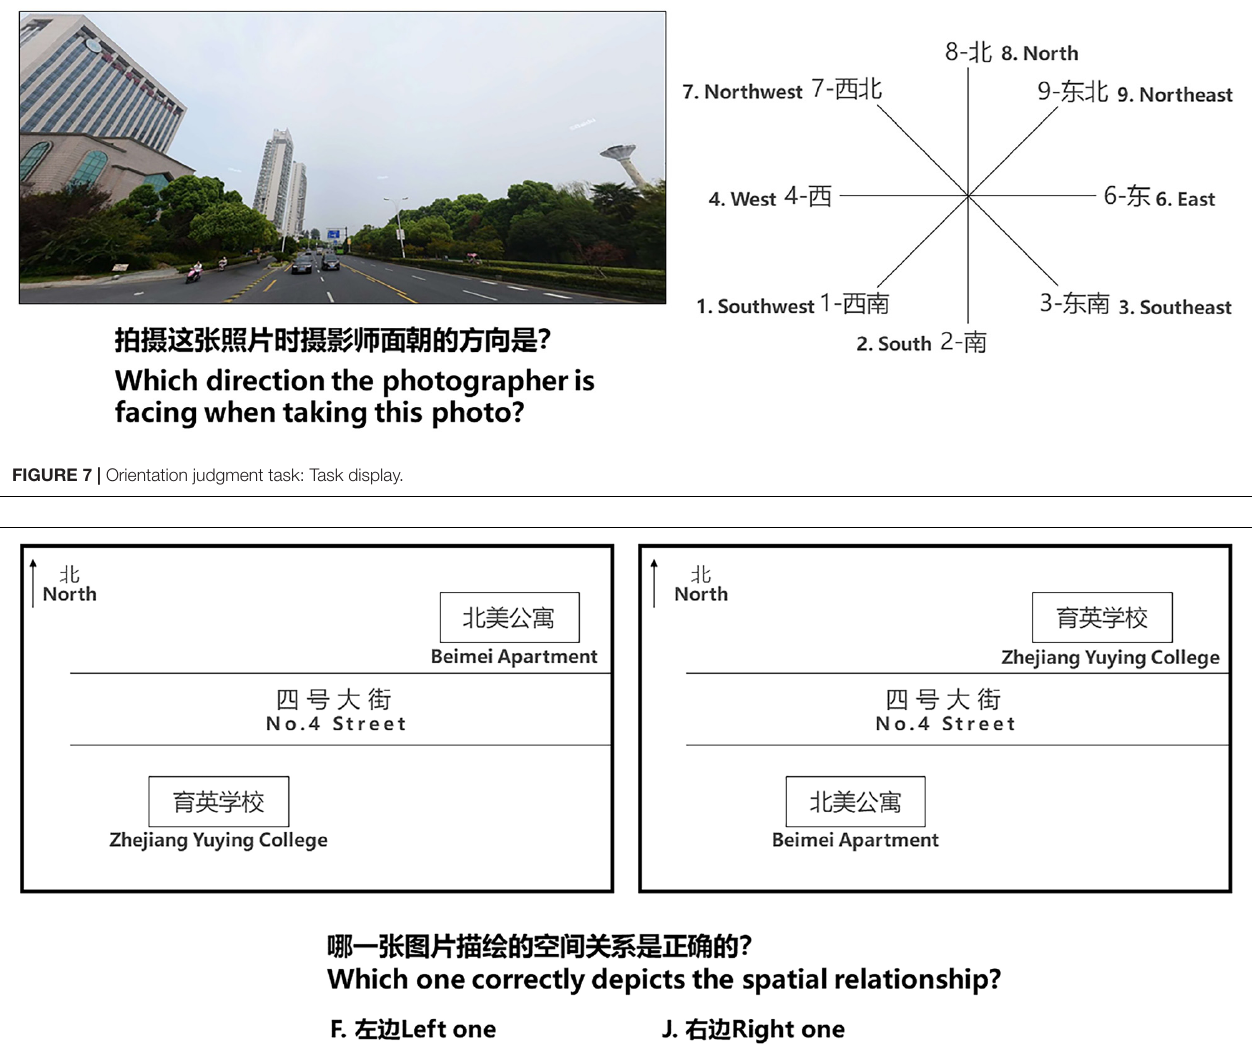
FIGURE 8 | Configurational representation task: Task display.